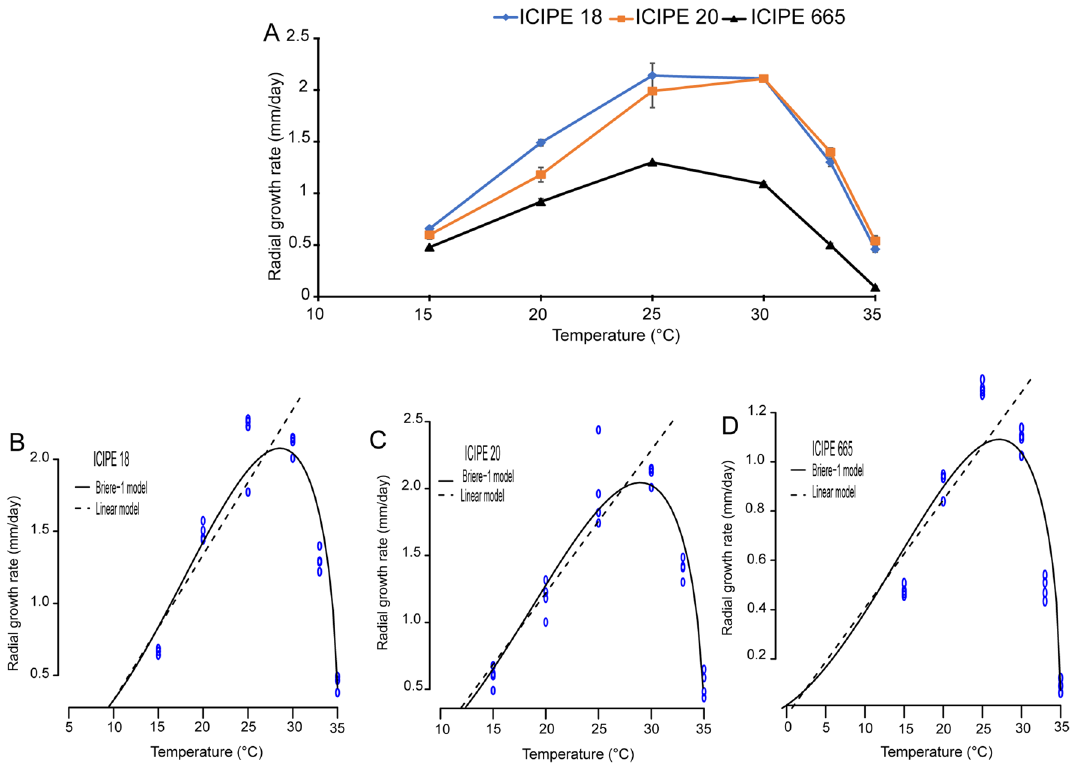
Figure 2. Relationship between temperature and radial growth rate of the three Metarhizium anisopliae fungal isolates. ( A ) Relative growth rates of Metarhizium anisopliae isolates ICIPE 18, ICIPE 20 and ICIPE 665 on SDA medium between 15 and 35 °C. Linear (dashed lines) and Brière-1 (continuous lines) nonlinear models fitted to observed values of the radial growth rate of Metarhizium anisopliae isolates ( B ) ICIPE 18, ( C ) ICIPE 20 and ( D ) ICIPE 665 at constant temperatures (n = 72; N = 4; Tukey’s HSD